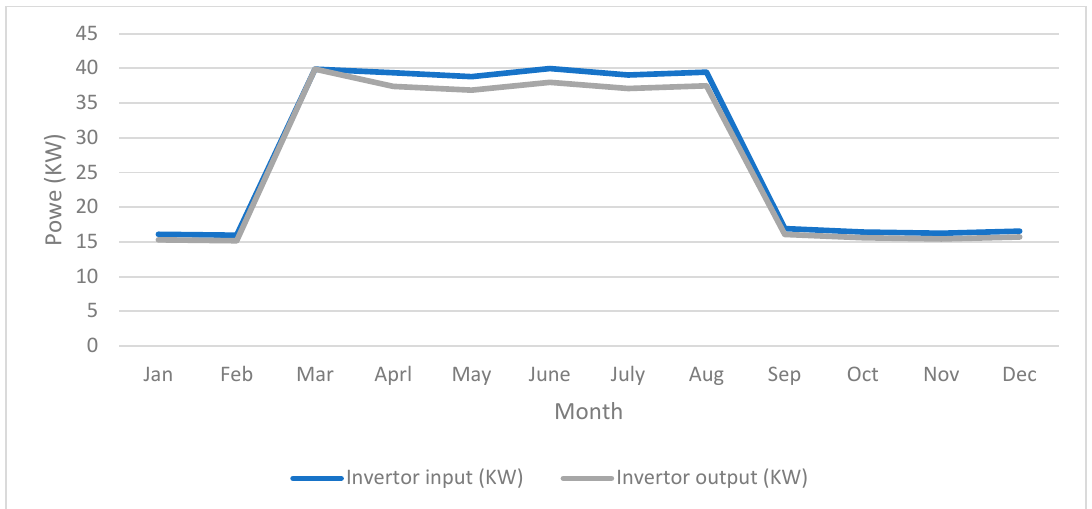
Figure 10. Monthly avg. inverter input and output (KW) .